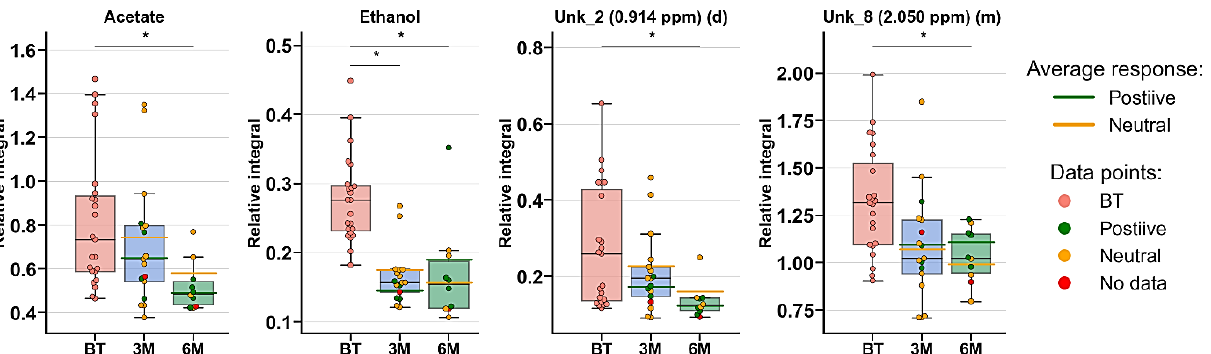
Figure 6. Boxplots for metabolites with VIP scores above 1.00 and statistical importance after p-value adjustment ( q < 0.05). Red bars—PsA patients before treatment; blue bars—3 months after initialization of anti-TNF treatment; green bars—6 months after treatment with TNFi. Whiskers—1.5 × interquartile range (IQR); bar—average; box—range between first quartile (Q1) and third quartile (Q3). Green line—average positive response for treatment; yellow line—average neutral response for treatment. Pink circle—data point for before treatment; red circle—data point for no information about response; green circle—data point for positive response for treatment; yellow circle—neutral response for treatment. * q value < 0.05 (precise values in Table S4). Table 3. The multivariate analysis models summary for PsA patients ’ treatment influence.